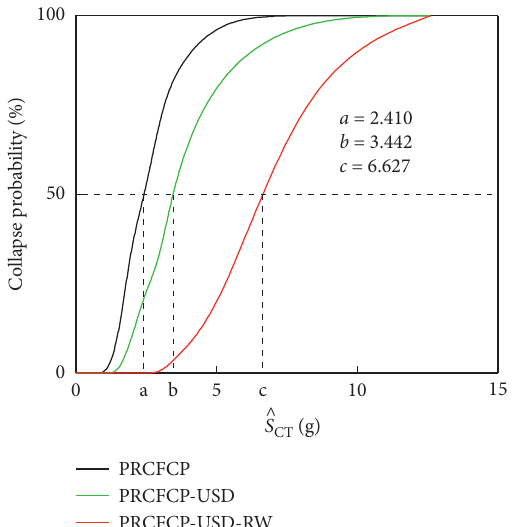
Figure 18: Comparison of the collapse fragility curves among the contrast models. Table 4: CMR of all models. Models